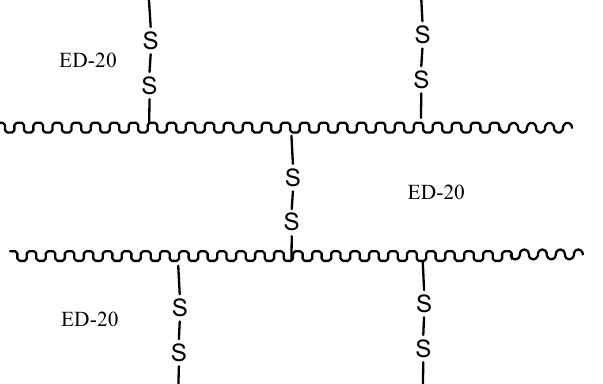
Scheme 2. Structure of the system contained NBR crosslinked with sulfur and epoxy dian resin. Such a position of ED-20 molecules affects rubber properties, which are represented in Tables 3 and 4 (see the next chapter). The properties depend on the amount of ED-20 introduced to the